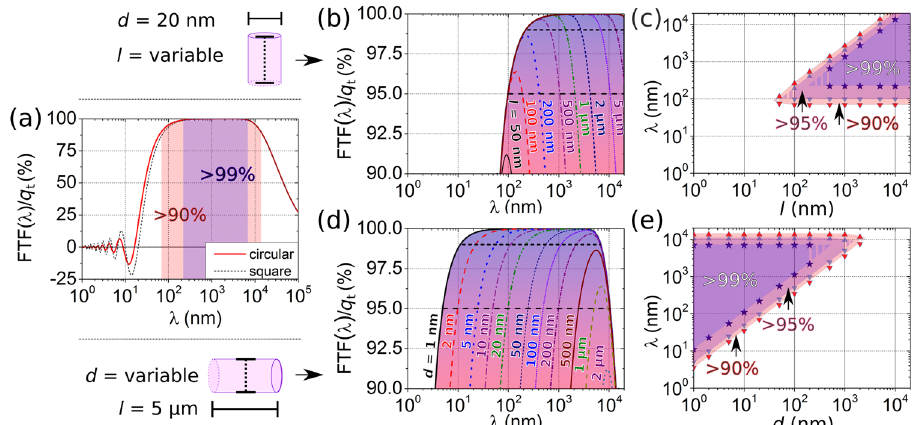
Fig. 4 Validation of the point monopole approximation. Normalized force transfer function FTF = q t for nanowire (NW) probes with circular cross-sections. a NW dimensions are: diameter d ¼ 20 nm and length ¼ 5 μ m. The red line refers to a calculation based on a circular NW cross-section. For comparison, results for a square-shaped NW are also shown (dotted line; note that a side of the square is aligned parallel to k xy ). Purple and reddish-colored areas indicate the λ ranges in which FTF ð λ Þ = q is >99% or >90%, respectively. k xy and λ ¼ 2 π = k xy are the wavevector and the wavelength of the spatial magnetic t fi eld distribution, respectively. b , c The impact of varying l is shown while d ¼ 20 nm is kept constant. d , e The impact of varying d is shown while l ¼ 5 μ m is kept constant. c , e λ (cid:4) l and λ (cid:4) d phase diagrams showing calculated areas with FTF = q ratios exceeding 99%, 95%, and t